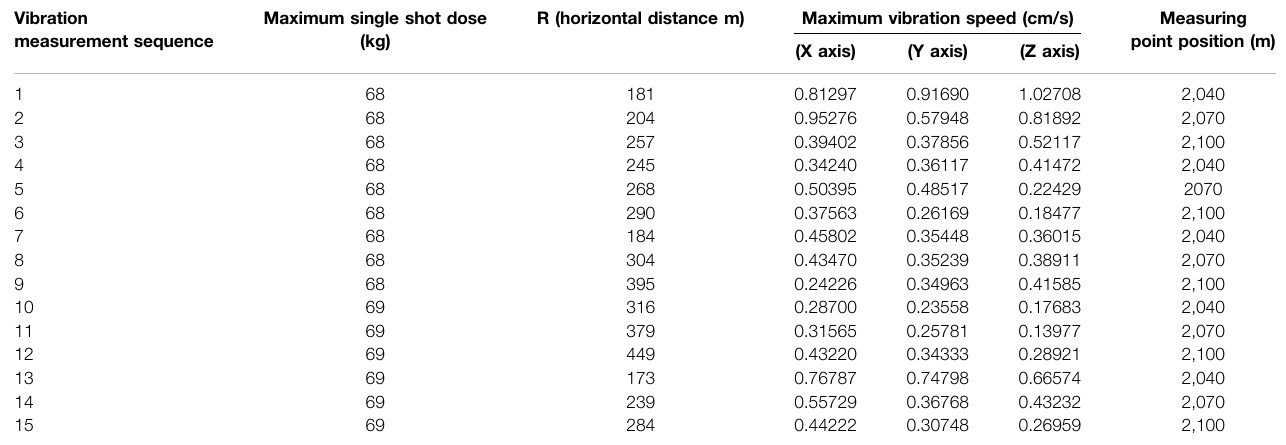
TABLE 2 | Typical vibration data statistics